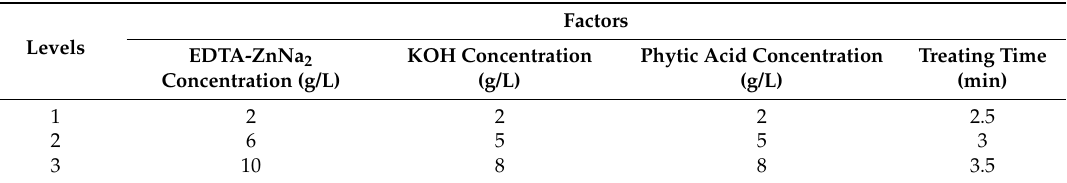
Table 1. Factors and levels of the orthogonal experiment.